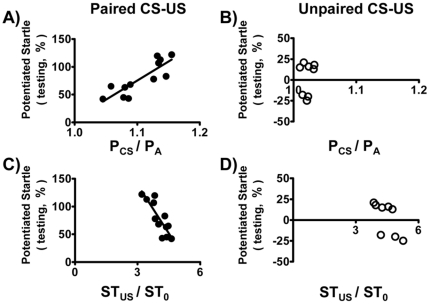
PCS/PA and STUS/ST0 in the learning session forecasted the performance of fear-potentiated startle.The trial-averaged values of both parameters in training sessions under paired CS-US conditions effectively established the fear-potentiated startle (A, C), but those under unpaired CS-US conditions were unable to do so (B, D).